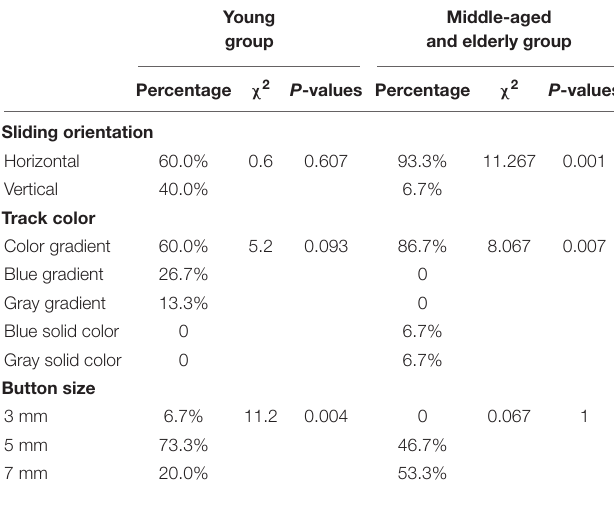
TABLE 6 | Distribution of user preference by sliding orientation, track color, and button